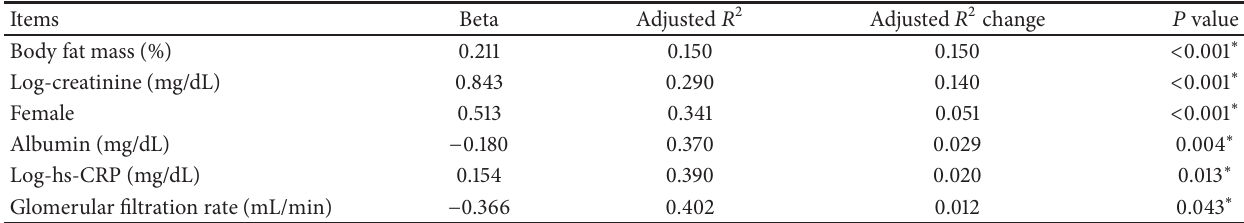
Table 4: Multivariable stepwise linear regression analysis of gender, height, body mass index, waist circumference, body fat mass, systolic bloodpressure,diastolicbloodpressure,albumin,totalcholesterol,log-triglyceride,log-HbA1c,log-BUN,log-creatinine,glomerularfiltration rate, log-CRP, log-insulin, and log-HOMA-IR: correlation to fasting serum adipocyte fatty acid binding protein level among 165 diabetic